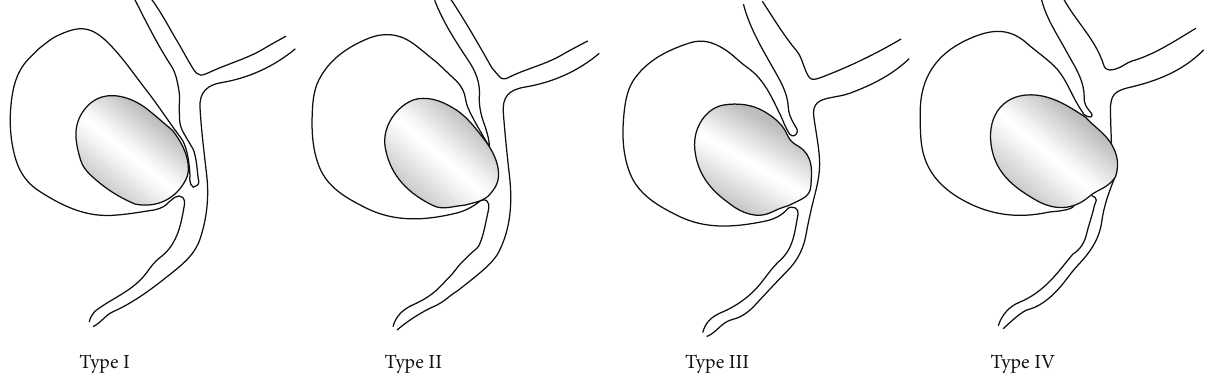
Figure 1: Classification of the Mirizzi’s Syndrome by